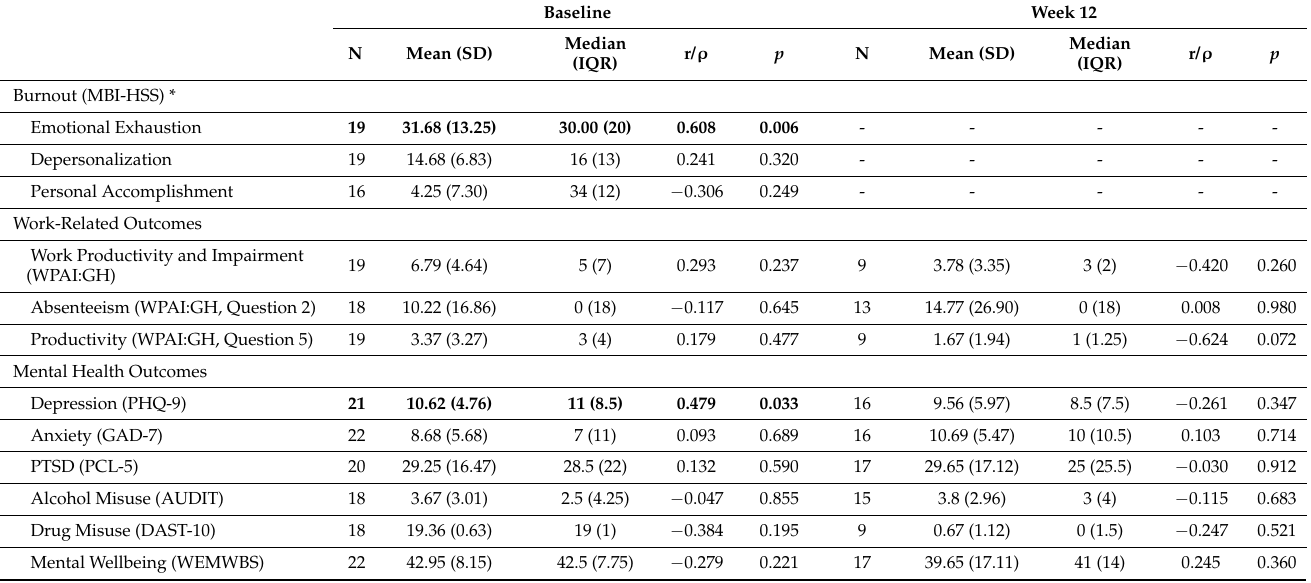
Table 9. Correlations between WAS and outcome measures.